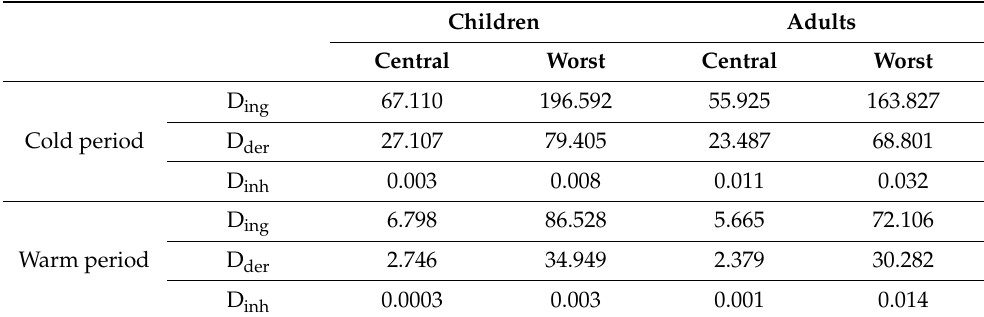
Table 2. The dose received (ng kg − 1 day − 1 ) through ingestion, dermal absorption and inhalation for carcinogenic PAHs in the PM 10 particle